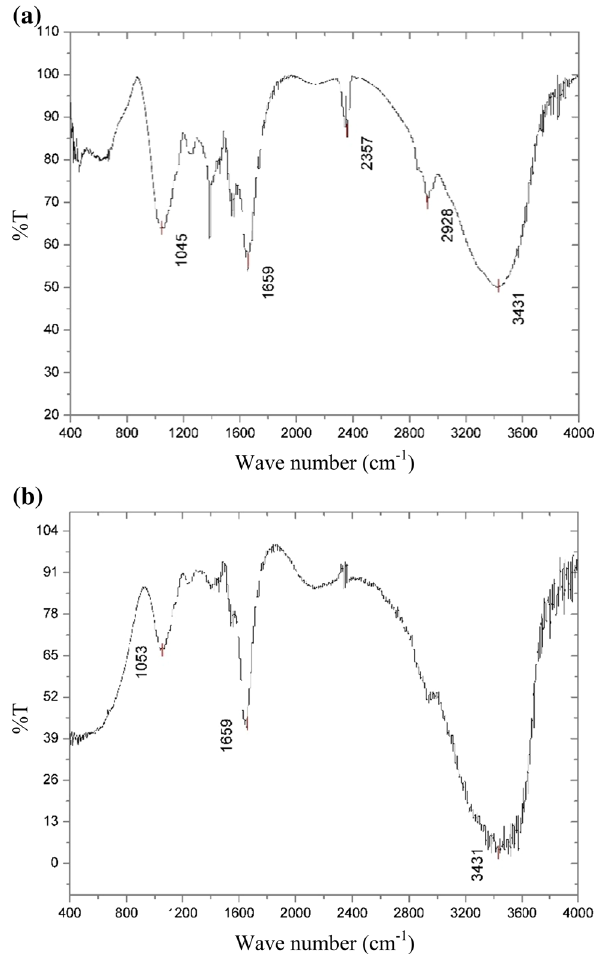
Fig. 4 a FTIR spectra of native cyanobacterial consortium and b FTIR spectra of chromium-loaded cyanobacterial consortium